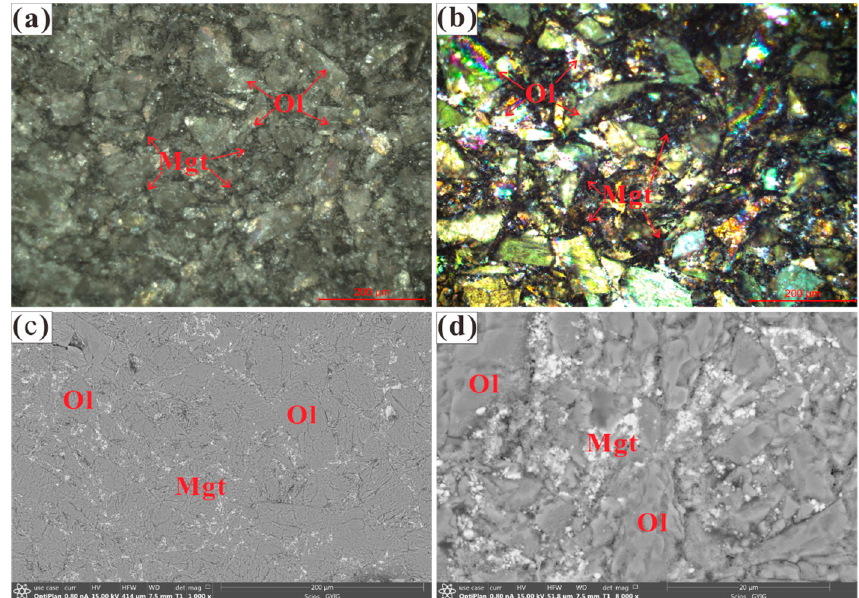
Figure 3. Representative microstructural observations of the recovered olivine aggregates with 5% volume fraction of magnetite. ( a ) and ( b ) microscopy images (plane-polarized reflected) acquired before and after the electrical conductivity measurements, respectively. ( c ) and ( d ) back-scattered electron images acquired with a scanning electron microscope before and after electrical conductivity measurements, respectively. Abbreviations are Ol olivine and Mgt magnetite.